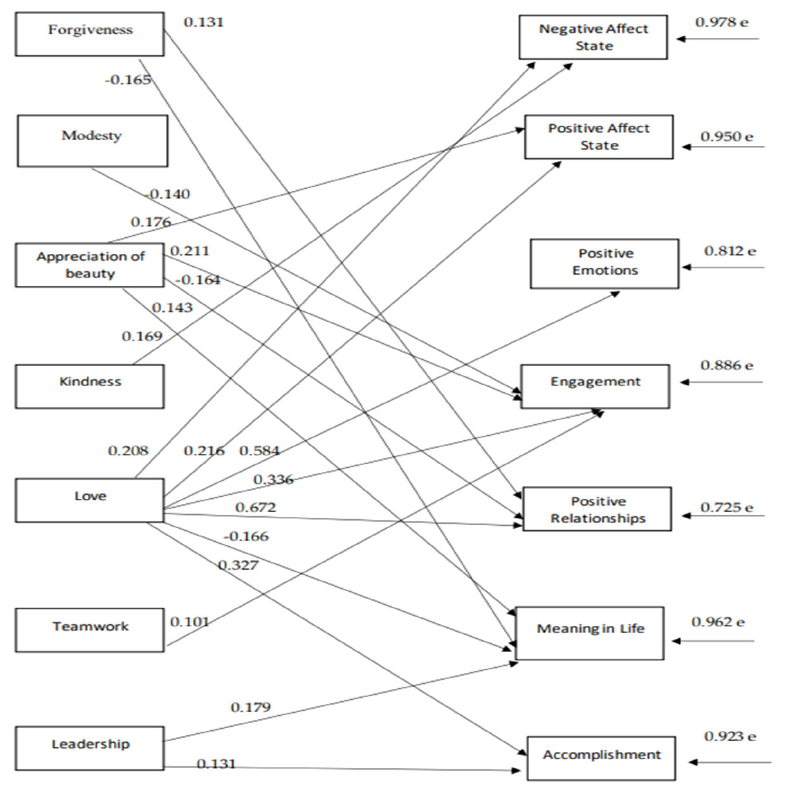
Figure 2. The relationships between interpersonal virtue dimensions and subjective wellbeing components.